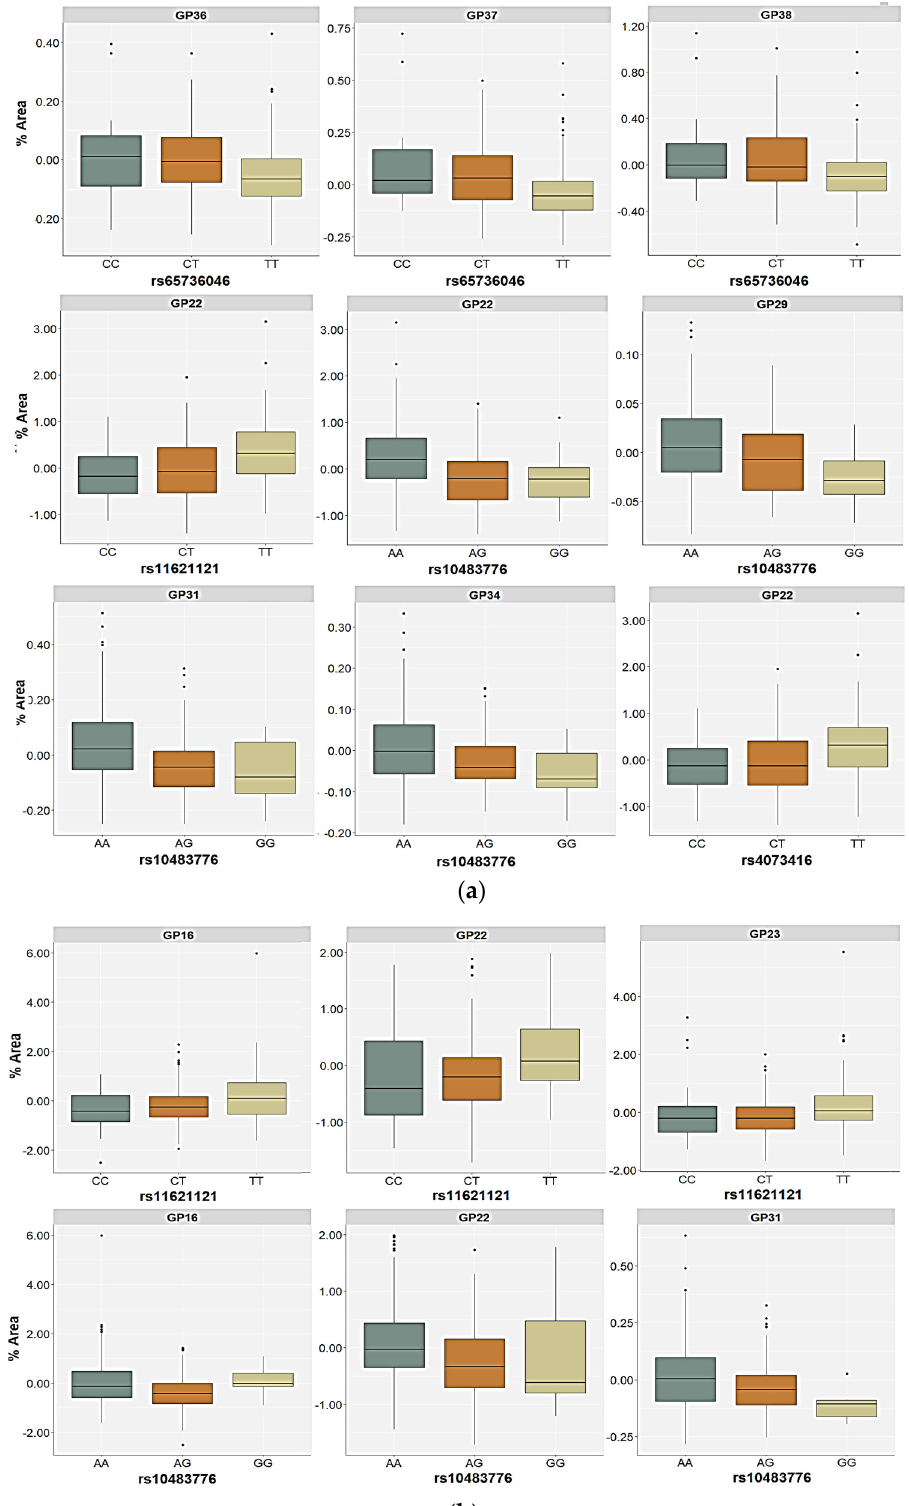
Figure 3. Relative distribution of the plasma N-glycan levels in the carriers of different genotypes for the rs6573604, rs11621121, rs10483776, and rs4073416 polymorphisms in the ( a ) control and ( b ) PTSD group. The central box represents the interquartile range of the age-adjusted percentage of the total glycan peak area, the middle line represents the median, the vertical line extends from the minimum to the maximum value, and separate dots represent the outliers.